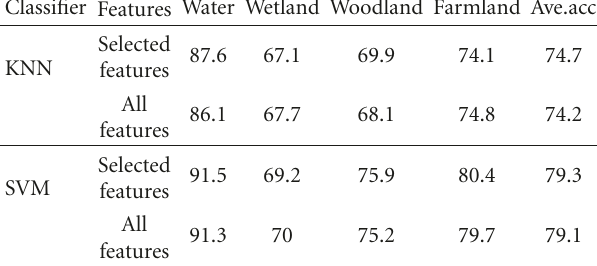
Table 3: Classification performances(%) of KNN and SVM with selected feature set and all features.